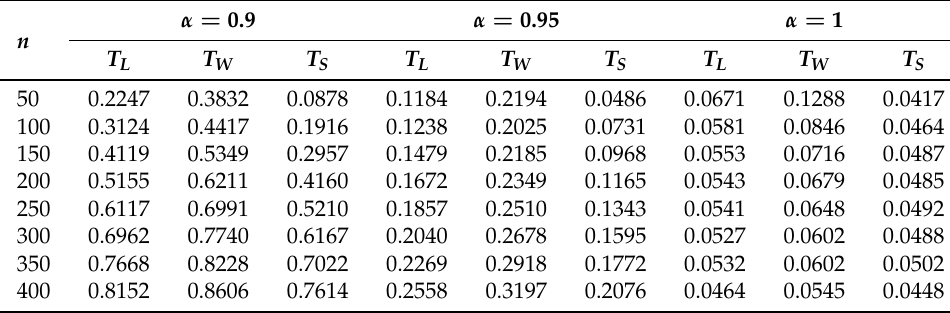
Table 8. The empirical levels/powers of statistics ( T L , T W , T S ) for Case (B3).